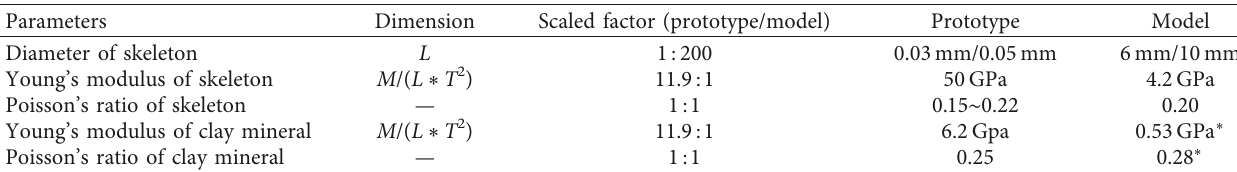
Figure 5: Relationship between Young’s modulus of the adhesive and temperature. Table 1: Model